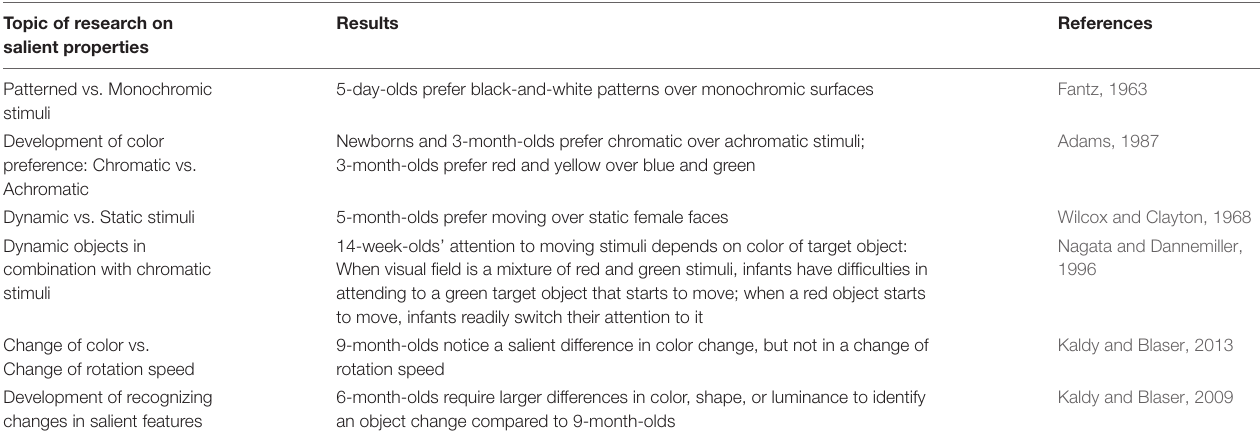
TABLE 1 | State of research on saliency in early infancy.